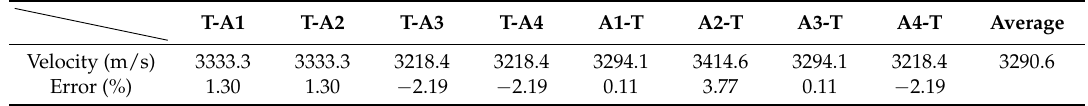
Table 2. The velocity computation result.